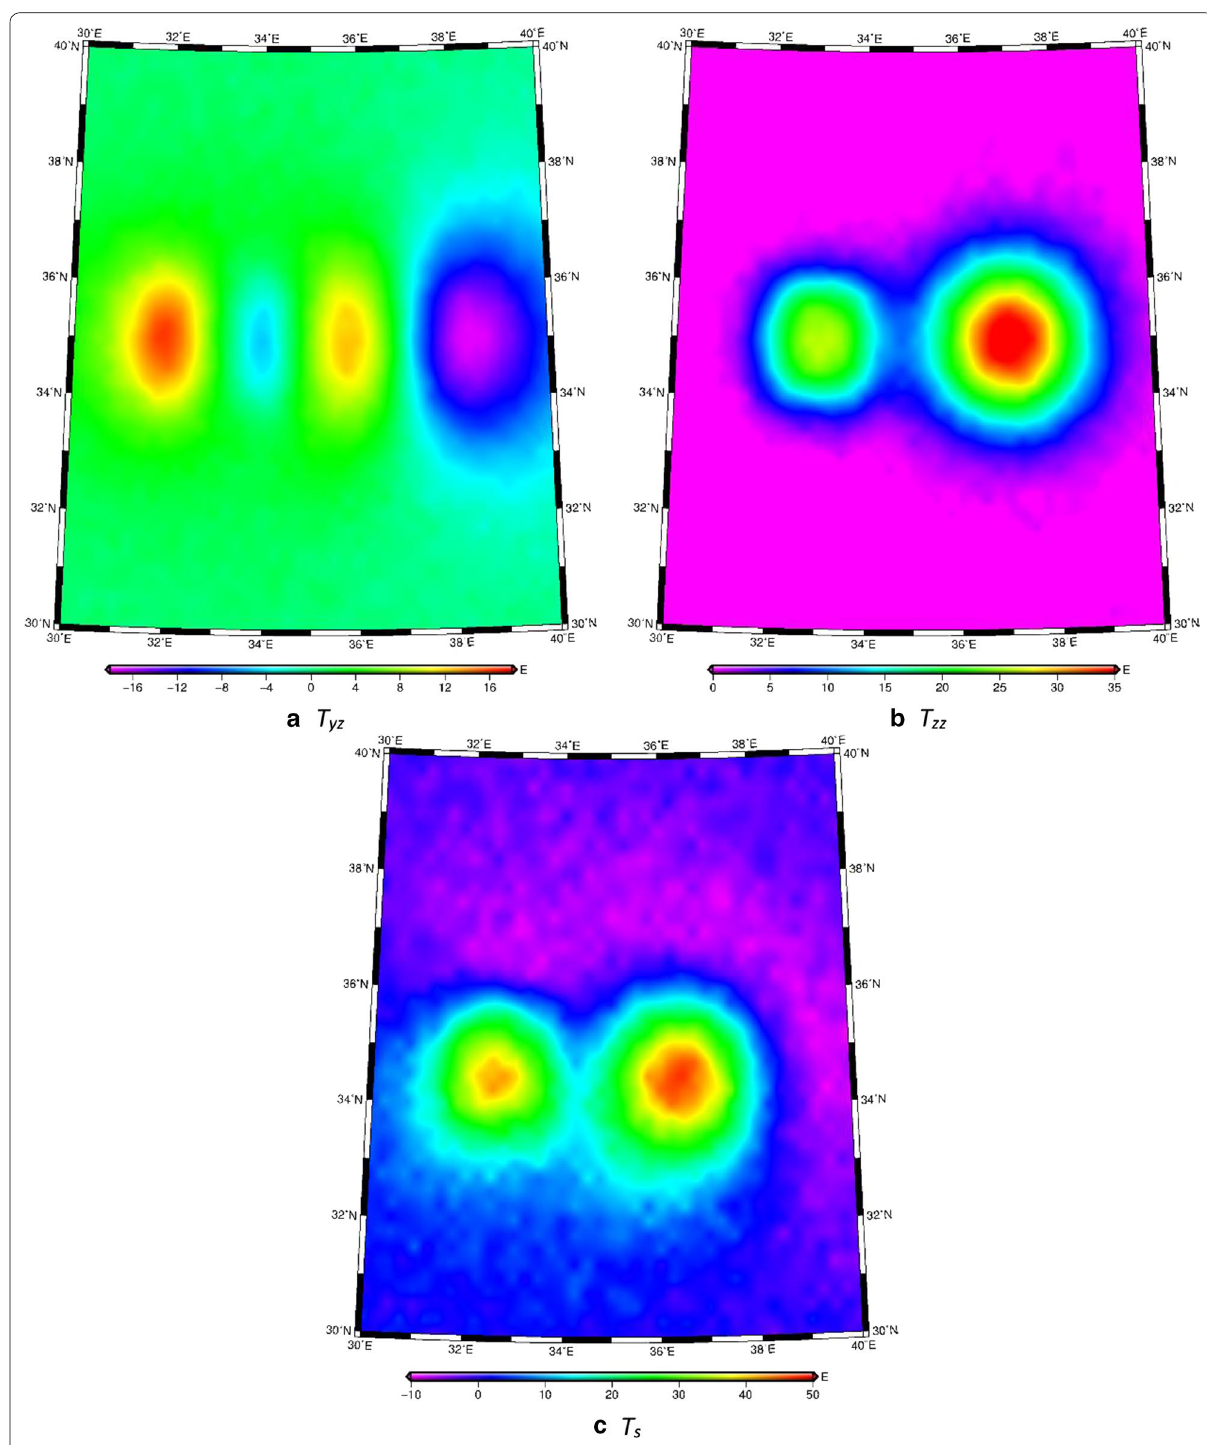
Fig. 12 Artificial theoretical datasets of the GGT with noise for composite models, a and b are T yz and T zz components of the GGT, respectively, and c T s is the summation of T xx , T xy , T xz , T yy , T yz and T